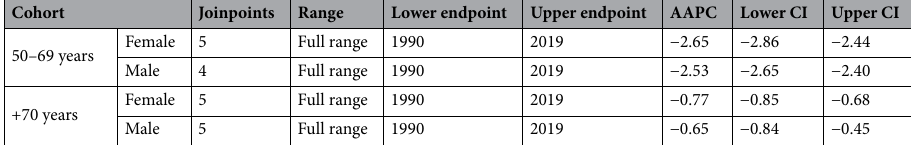
Table 1. Descriptive statistics of CVD mortality are separated by gender and age.